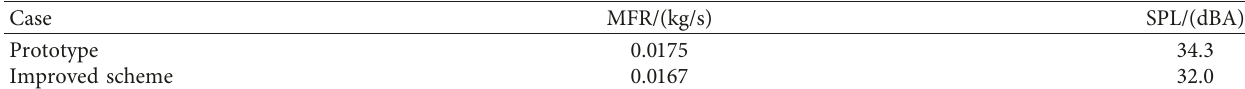
Table 3: Simulation